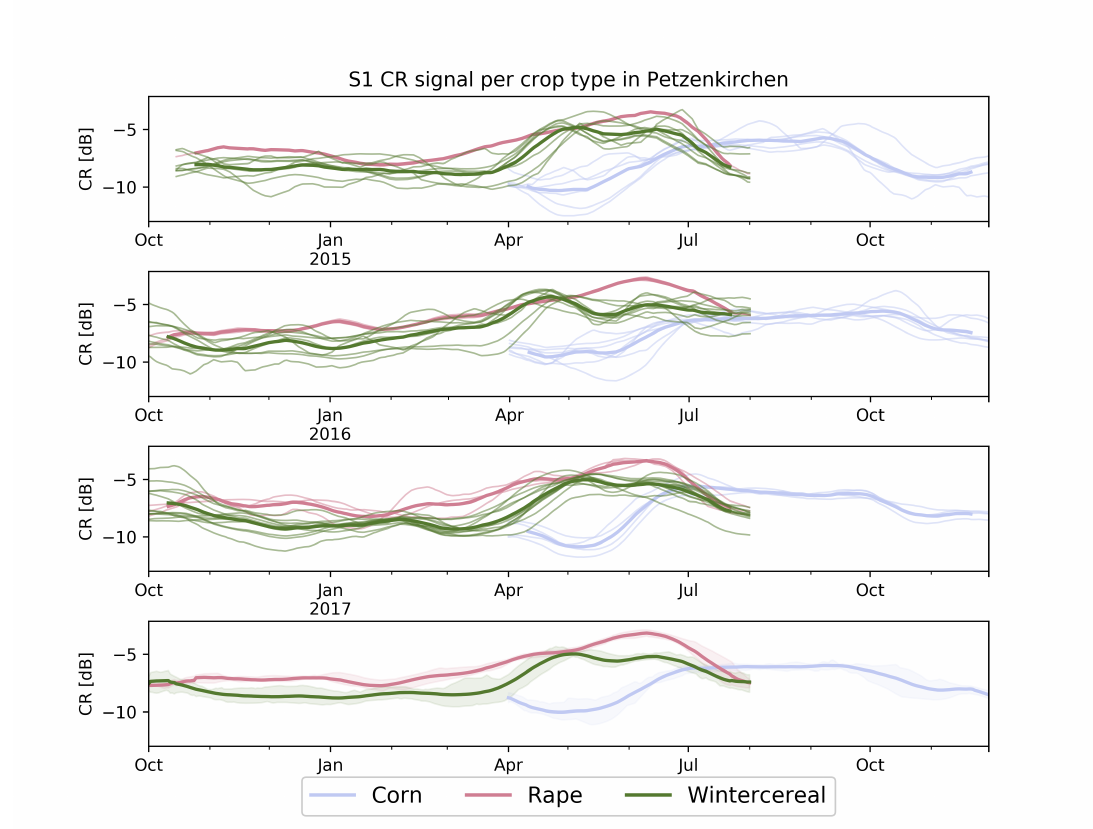
Figure 8. Cross Ratio of Sentinel-1 for different crop types per year (2015–2017) and averaged over all fields and years (lower window). The shaded areas represent the 25th and 75th